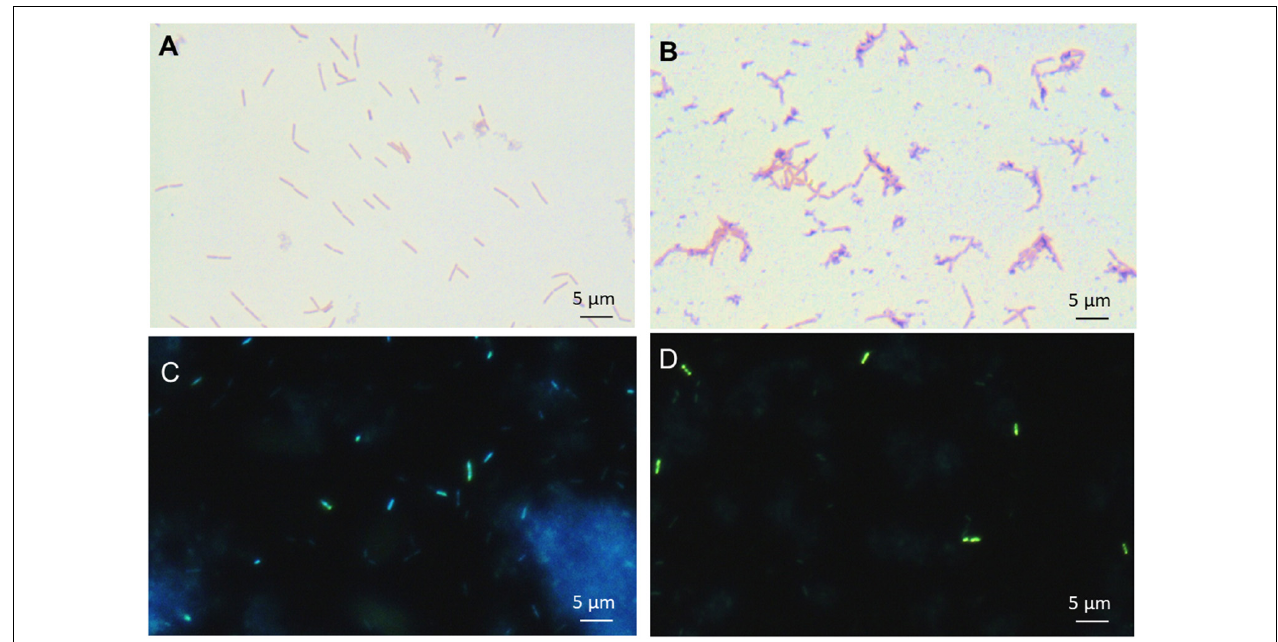
FIGURE 2 | Hyperconcentrated sweet whey triggers intracellular accumulation of polyphosphate granules in L. casei BL23. Lactobacilli were cultivated 48 h in isotonic 5% (A,C) or hyperconcentrated 30% (B,D) sweet whey. Polyphosphate metachromatic granules were evidenced by Neisser staining of fixed culture smears prior to microscopy observation at x1000 magnification (A,B) . Polyphosphate was visualized by DAPI staining prior to epifluorescence microscopy (C,D) observation. Green fluorescence indicates cytosolic poly P and blue fluorescence DNA. The scale bar indicates the length corresponding to 5 µ m.